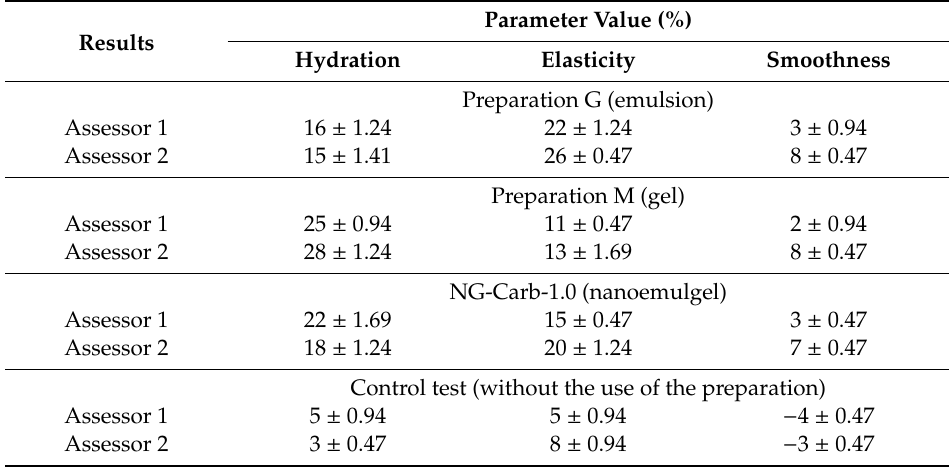
Table 8. Results of the examined preparations concerning their e ff ect on the skin after thermal